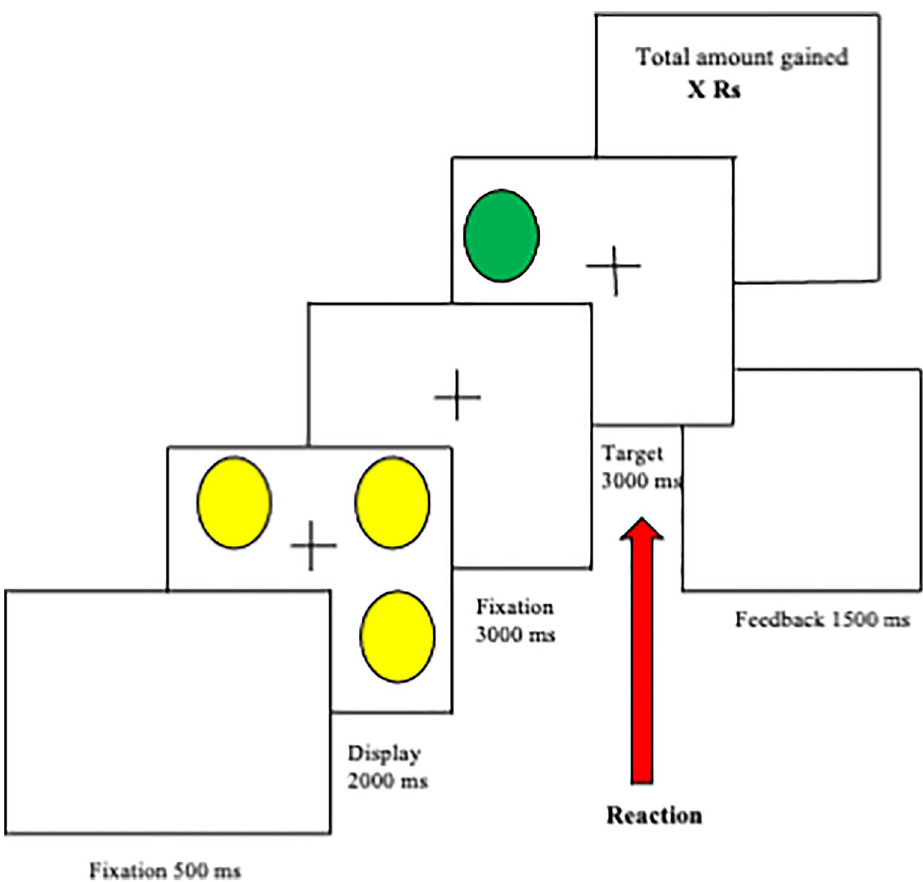
Figure 1. Schematic representation of a trial of the Fribourg Reward Task with 3 circles. This figure shows the schematic representation of a trial of the reward task with 3 circles. In the first display, an array of yellow circles (3 circles) was presented for 2000 ms after a fixation time of 500 ms. After a delay of 3000 ms, a green circle appeared, and the subject had 1500 ms to decide whether the position of the green circle was the same as that of one of the preceding yellow circles. If so, the correct response for participants was to press a button with their right hand. If not, the participants had to press a button with their left hand. After the response time had elapsed, the circle disappeared, and the accumulated amount of money earned appeared on the screen in the reward condition or nothing is shown on the screen in the no-reward condition. During the reward condition, the participants should earn a monetary reward for every correct response.